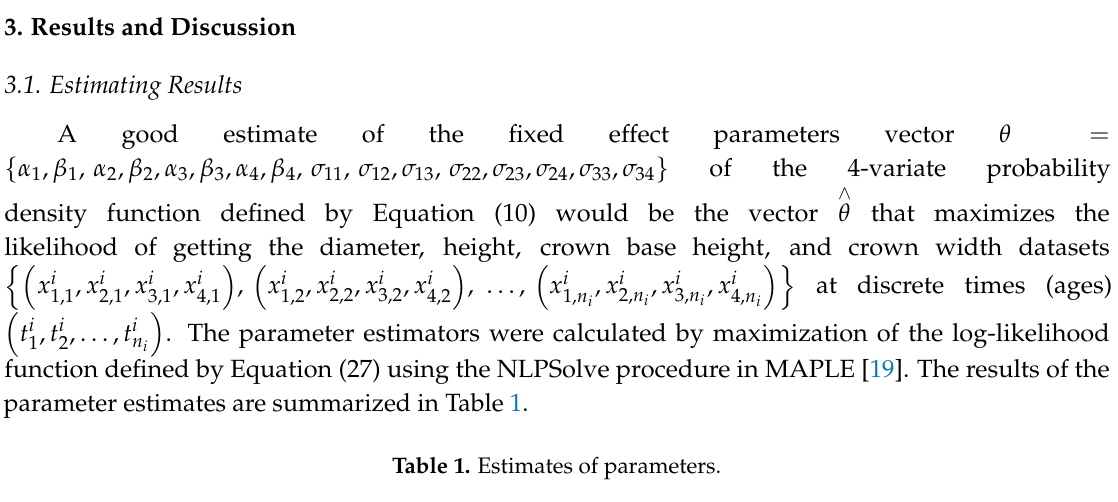
Table 1. Estimates of parameters.